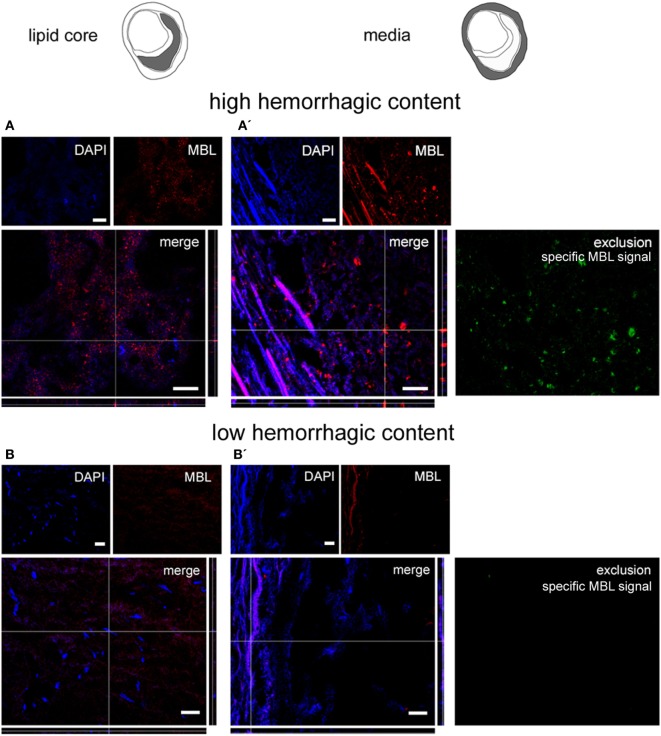
Mannose-binding lectin (MBL) presence in plaques. Microphotograms of the lipid core (left) and tunica media (right). MBL was present in lipid core and tunica media in high hemorrhagic [hemorrhagic content >1.98% (A,A′)] but not in low hemorrhagic (B,B′) plaques as further confirmed by the exclusion images. Nuclei are blue. Scale bars = 20 μm.